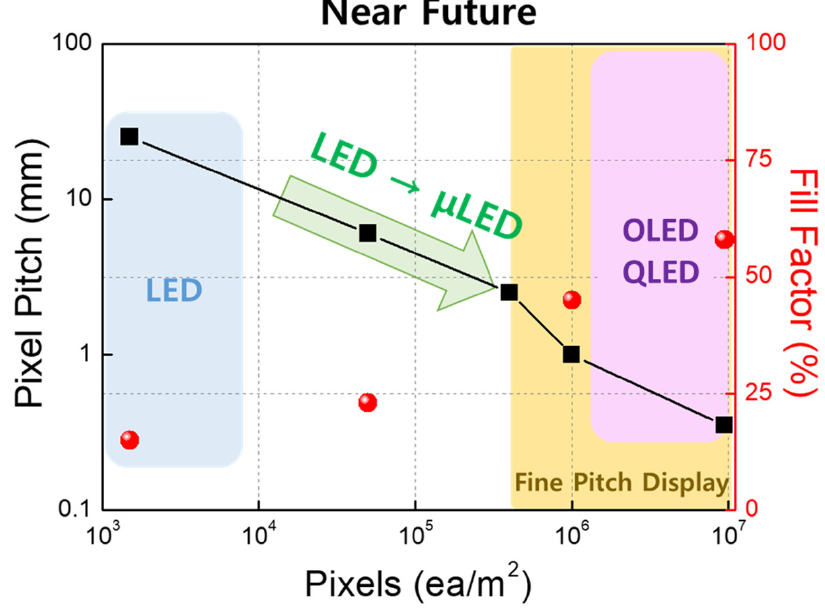
Figure 3. Development prospect of light sources as display components.